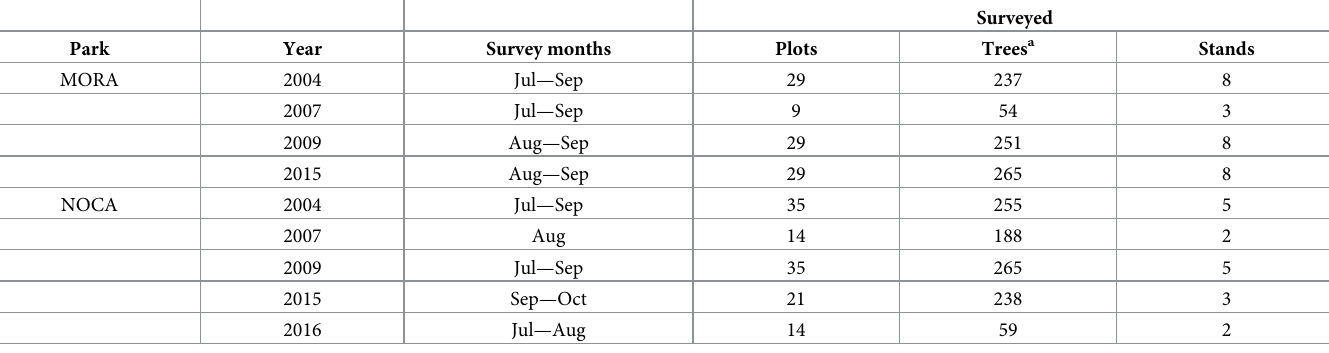
Table 1. Whitebark pine surveys conducted in Mount Rainier National Park (MORA) and North Cascades National Park Complex (NOCA), park units within the North Coast and Cascades Inventory and Monitoring Network (NCCN). These data were used for temporal analyses. Surveyed Park Year Survey months Plots Trees a Stands MORA 2004 Jul—Sep 237 8